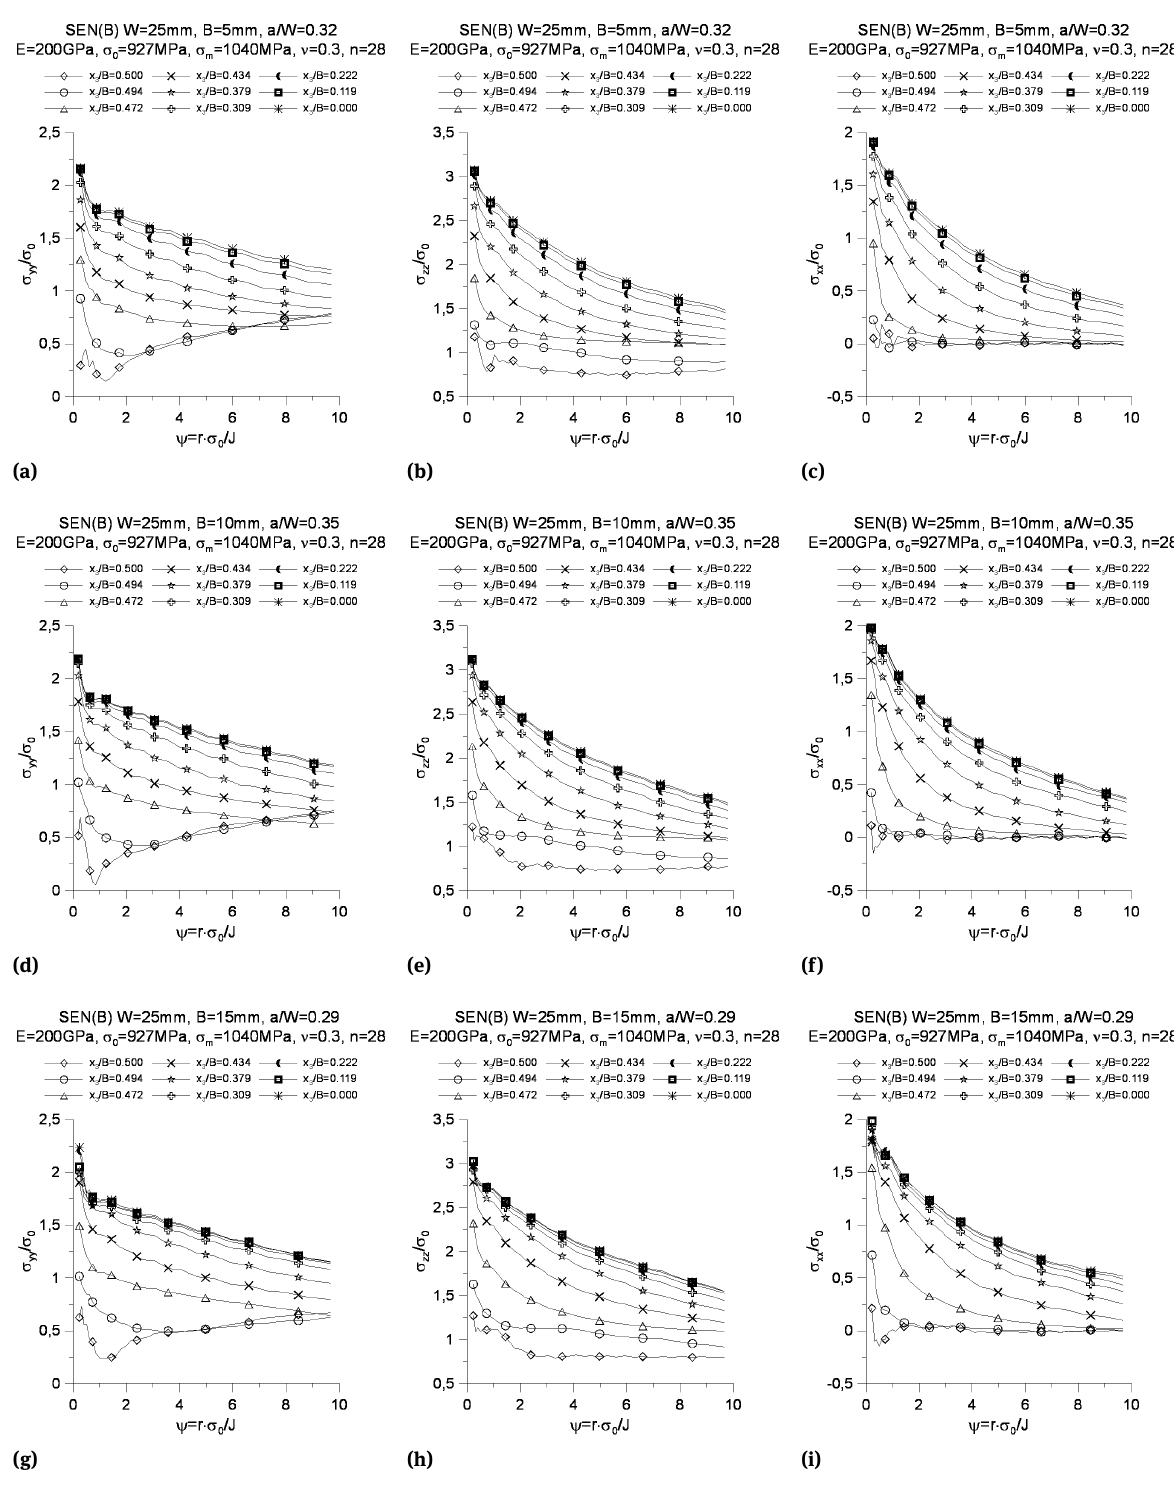
Figure 6: The normal stress distributions near the crack tip for three SEN(B) specimens made of 145Cr6 steel: a-c) B = 5mm, a / W = 0.32 ; d-f) B = 10 mm, a / W = 0.35 ; g-i) B = 15 mm, a / W = 0.29 ( x 3 / B = 0.500 – the edge of the specimen; x 3 / B = 0.000 – the middle plane of the specimen